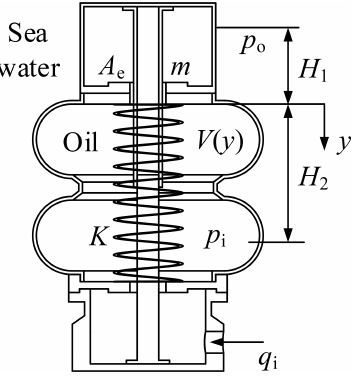
Figure 2. Rubber bellows type pressure compensator at a transient equilibrium